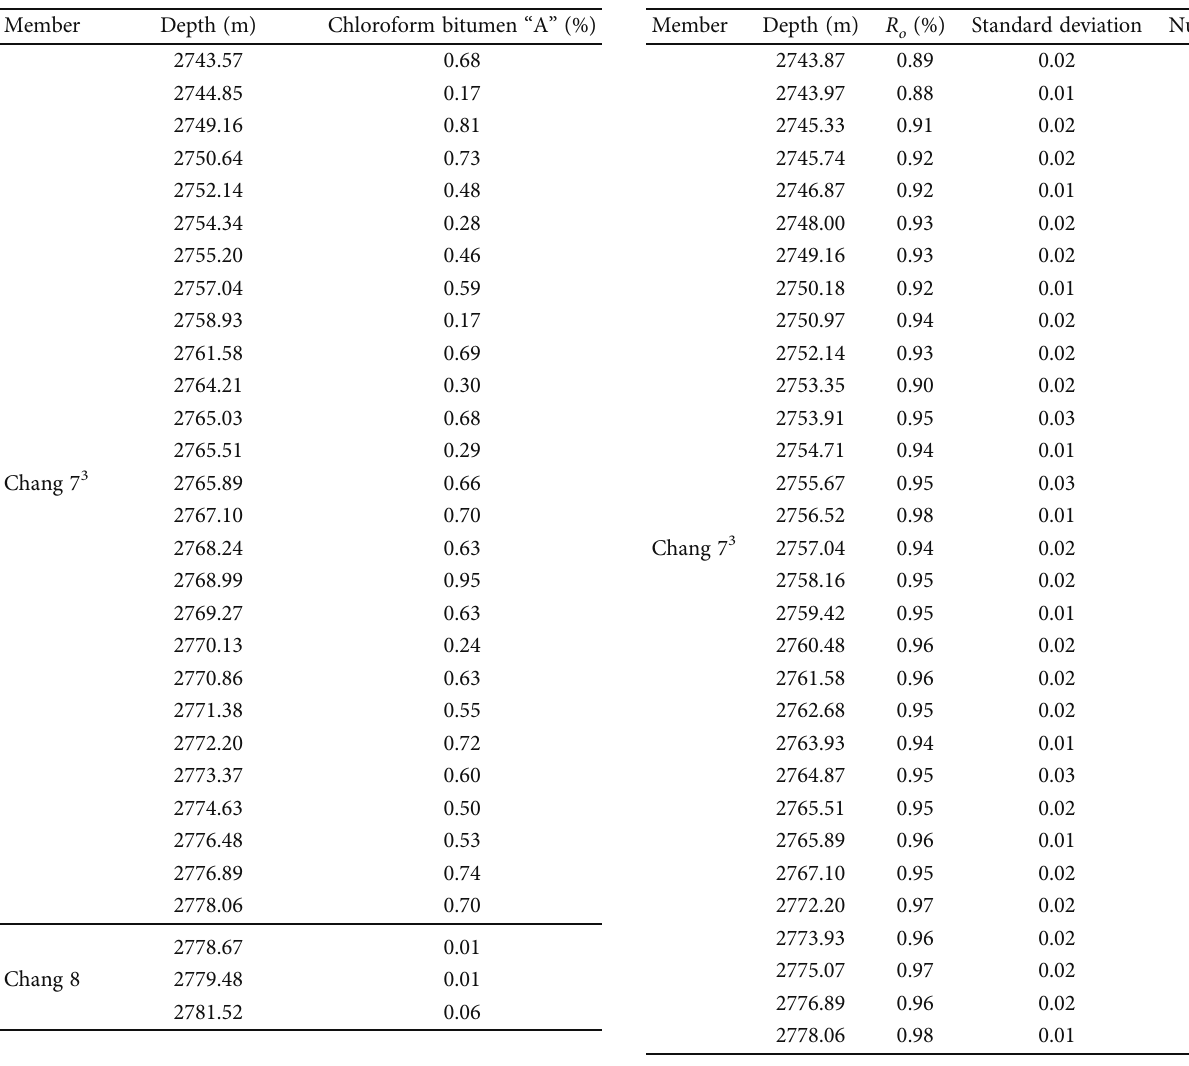
Table 3: Chloroform bitumen “ A ” content of Chang 7 3 and Chang 8 intervals from well DP1 in the western Ordos Basin.